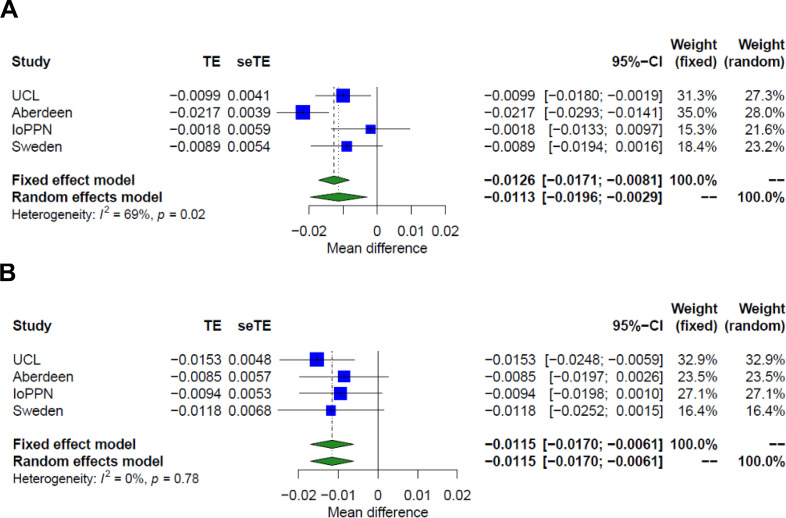
Additive effect of schizophrenia and treatment resistance on CD8+ T-cell proportions.Shown are forest plots from meta-analyses of differences in estimated granulocyte proportions derived from DNA methylation data between (A) schizophrenia patients and controls and (B) treatment-resistant schizophrenia patients prescribed clozapine and schizophrenia patients prescribed other medications. TE: treatment effect (i.e., the mean difference between cases and controls); seTE: standard error of the treatment effect.